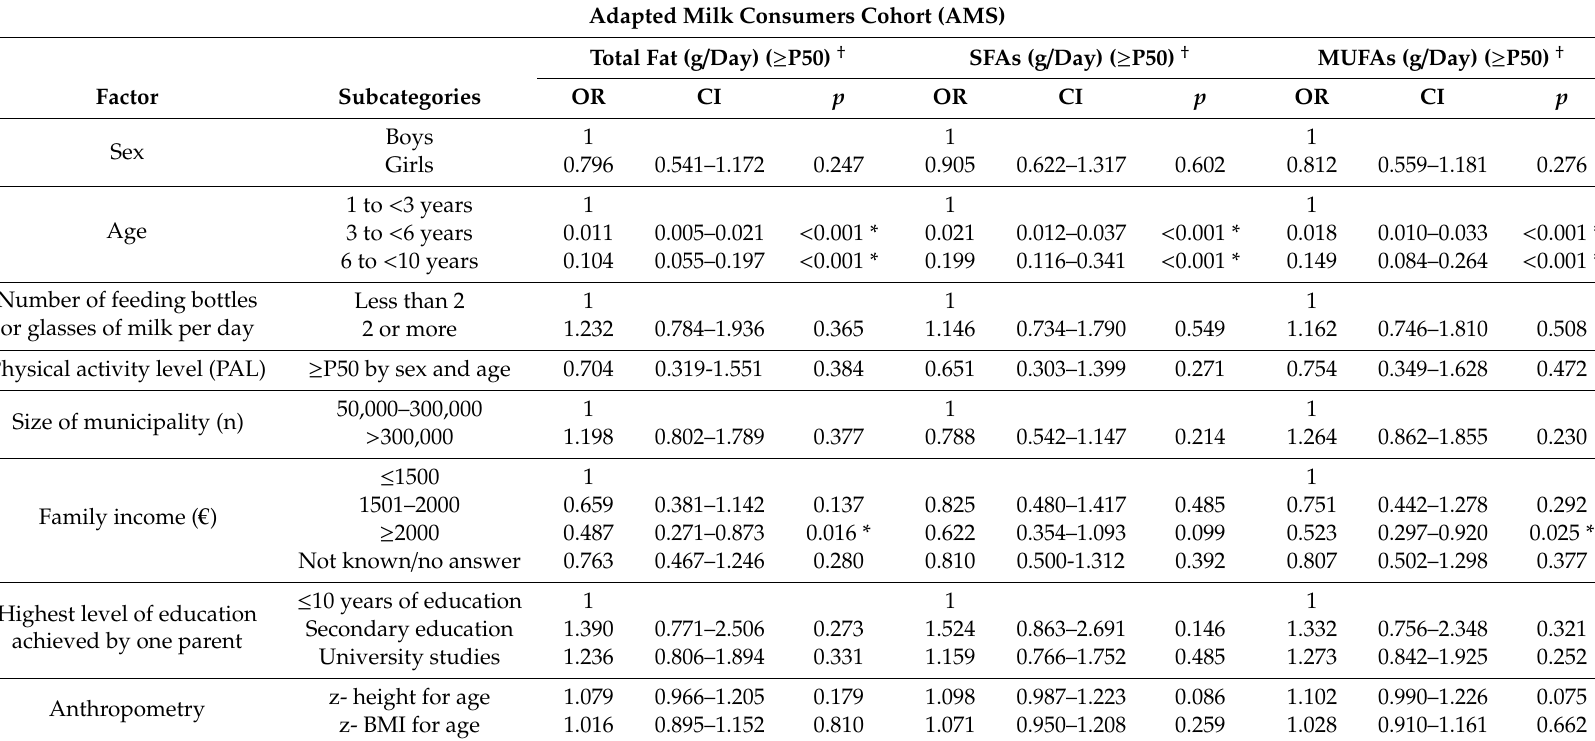
Table 11. Odds ratios and 95% confidence intervals for intake equal to or higher than the median of fat, saturated fatty acids, and monounsaturated fatty acids relative to family and personal factors in adapted milk consumers cohort of Nutritional Study in the Spanish Pediatric Population (EsNuPI) ( n =